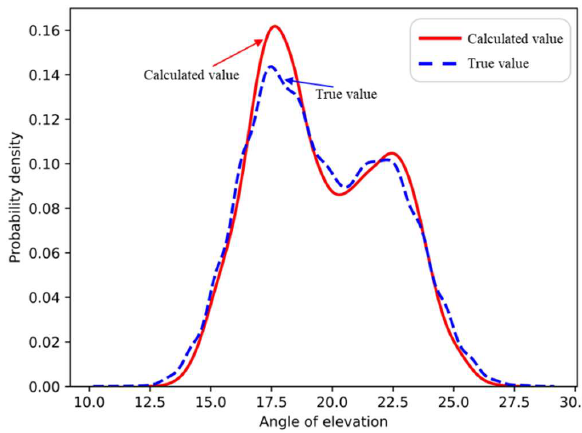
Figure 9. Comparison of elevation angle distribution